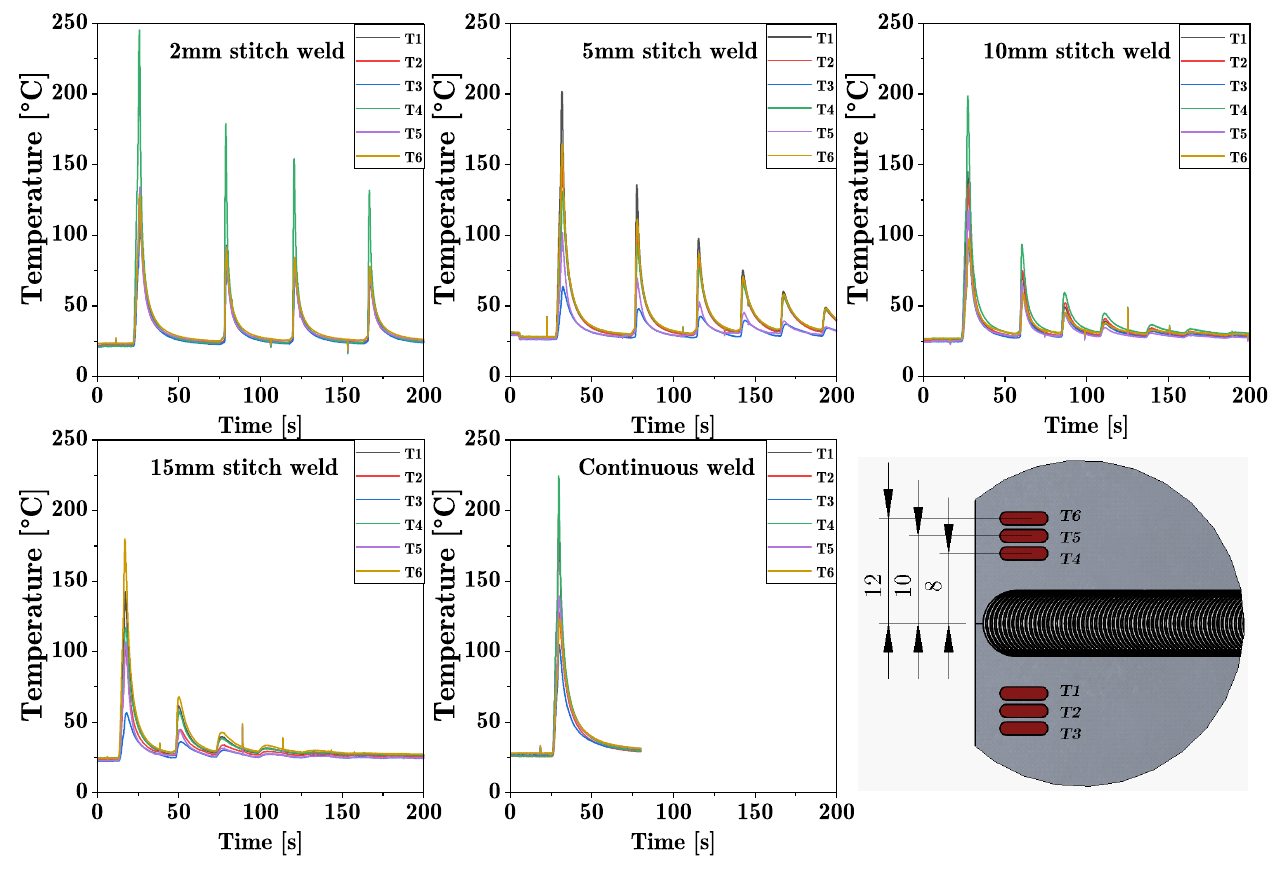
Figure 9. Thermocouple signals of all stitch welds in comparison to the continuous FSW and the positions of the thermocouples to the weld (all dimensions in